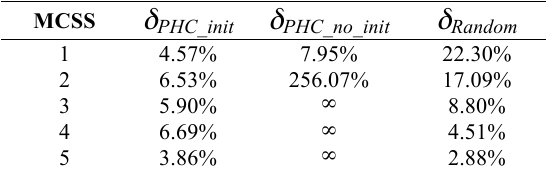
Table 2. USDEA Improvement Statistics for Mesh